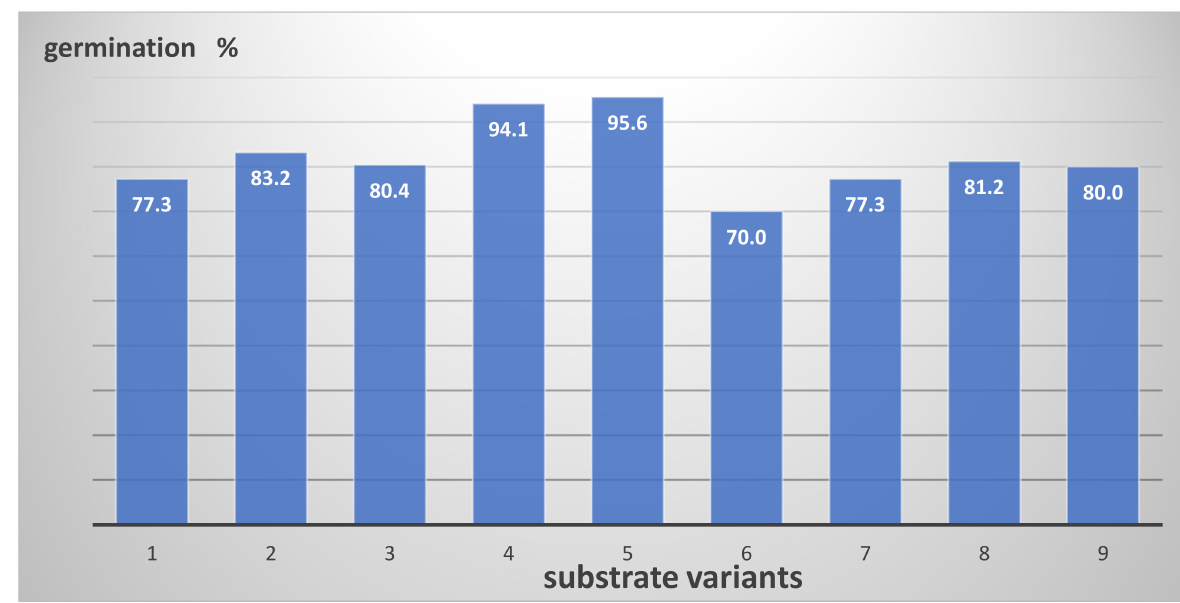
Figure 4. Average germination percentage of English oak seeds in containers with different substrate composition Variants: 1. Soil (control); 2. Peat:S = 1:1; 3. Peat:S = 1:2; 4. Peat:S = 2:1; 5. Peat:S = 3:1; 6. S:H:SD = 1:1:1; 7. S:H:SD = 2:1:1; 8. S:H:SD = 3:2:1; 9. S:H:SD = 4:2:1 (P—peat; S—soil;